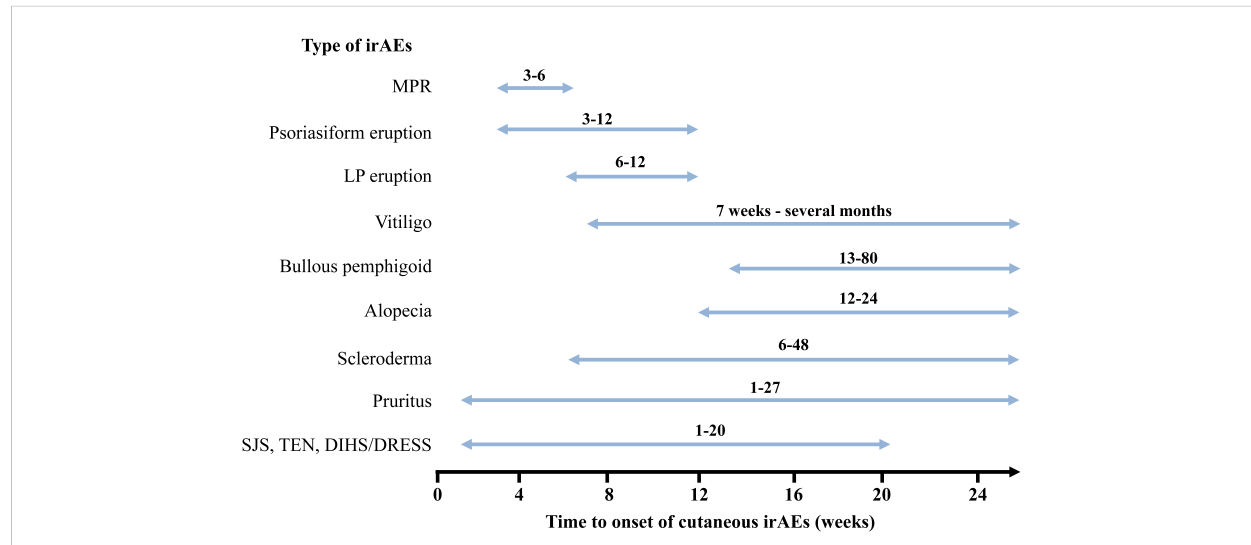
FIGURE 6 Time to onset of cutaneous immune-related cutaneous adverse events. MPR, Maculopapular rash; SJS, Stevens-Johnson Syndrome; TEN, toxic epidermal necrolysis; DIHS, Drug-induced hypersensitivity syndrome; DRESS, Drug reaction with eosinophilia and systemic symptoms; irAEs, immune-related cutaneous adverse